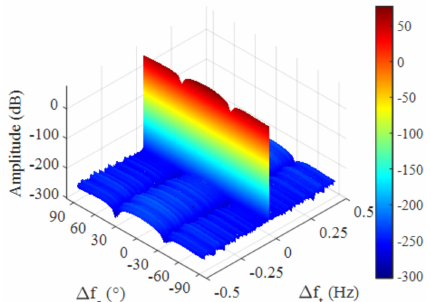
Figure 6. The correlation coefficients between v c